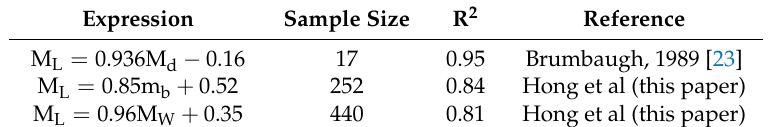
Table 2. Mathematical regressions adopted and derived to homogenize M d , m b and M w seismic magnitudes to local (Richter) magnitude, M L .